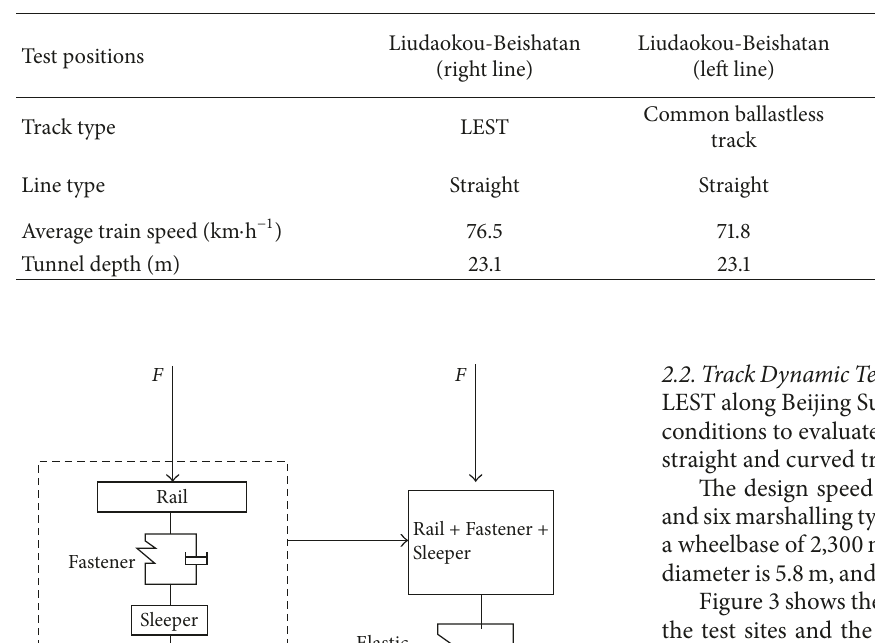
Table 1: Profile of test positions in Beijing Subway Line 15.